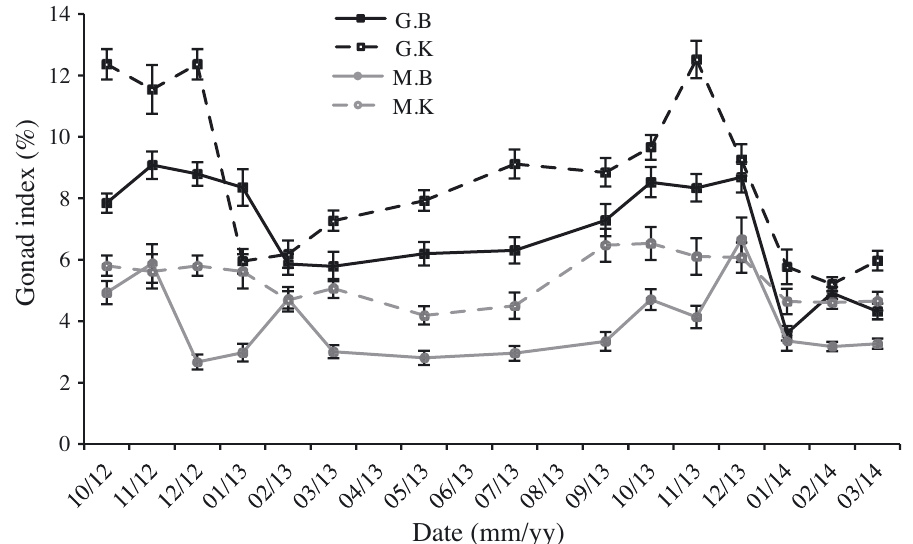
Fig. 2. Expt 1: mean ± SE gonad in- dex of purple urchins Heliocidaris erythrogramma from Gellibrand urchin barrens (G.B; dark grey, solid line) and kelp beds (G.K; dark grey, dashed line), and Mornington ur - chin barrens (M.B; light grey, solid line) and kelp beds (M.K; light grey, dashed line). Urchins were collected monthly or bimonthly from